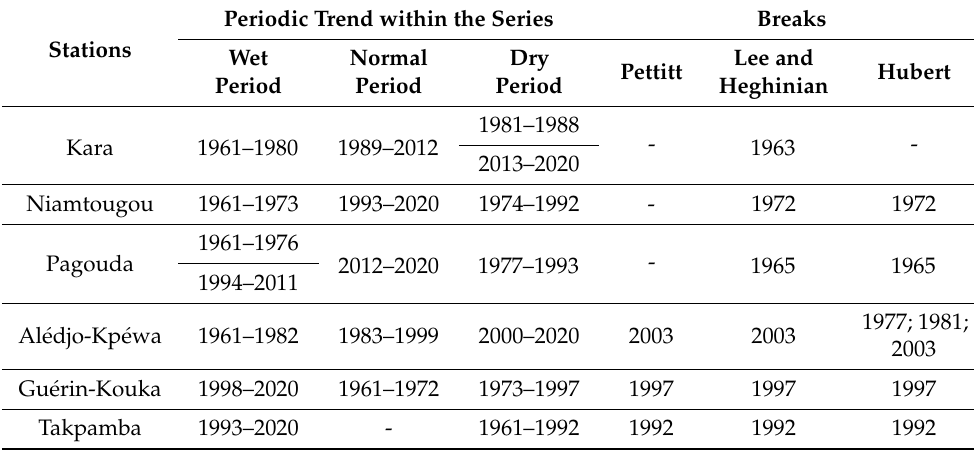
Table 2. Alternation of different phases and breaks detected within the precipitation series recorded at the measuring